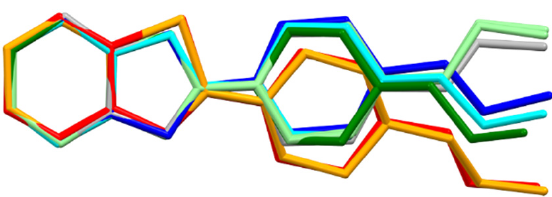
Figure 21. Overlay of molecules for all determined structures; 1 is blue, 2 is red, 3 is cyan, 4 is orange, 5 is green, 6 is light green and 7 is grey.